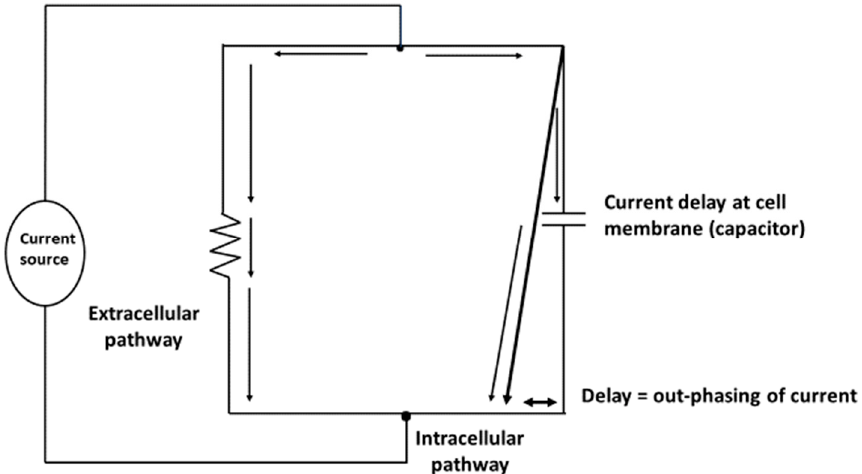
Figure 2. Representation of the body as a parallel resistor-capacitor (RC) equivalent circuit. Delay of the current penetration at the cell membrane causes an out-phasing of current.